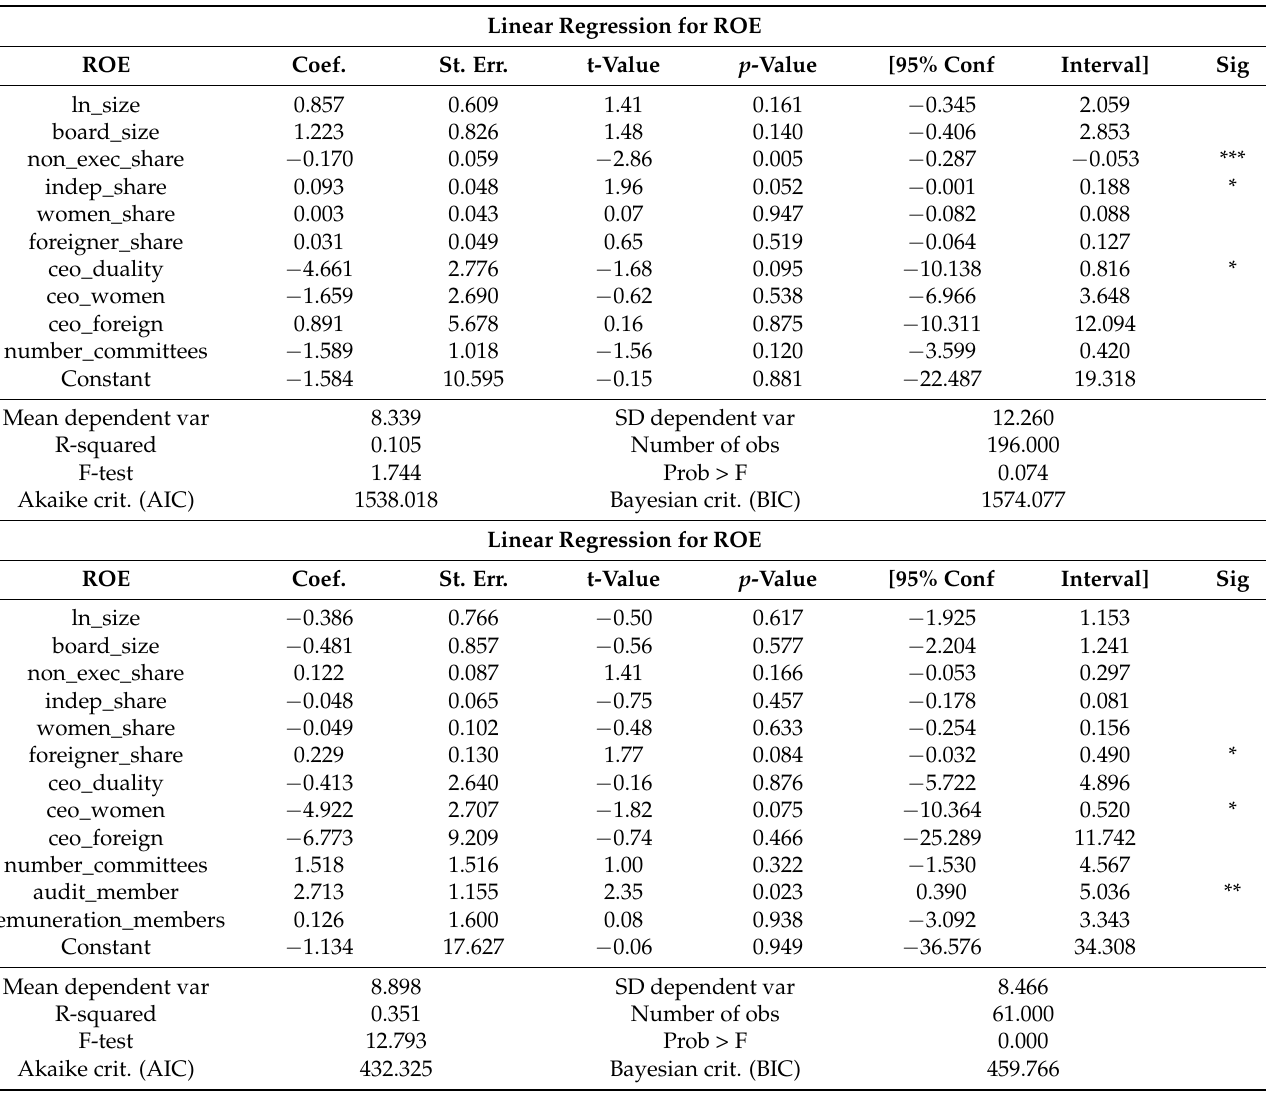
Table 7. OLS regression results with full set of independent variables. Linear Regression for